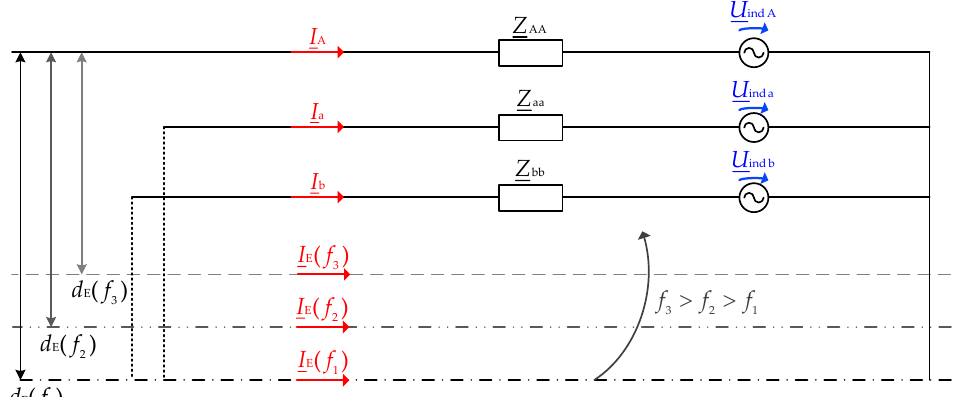
Figure 2. Inductively coupled loops with fictive earth